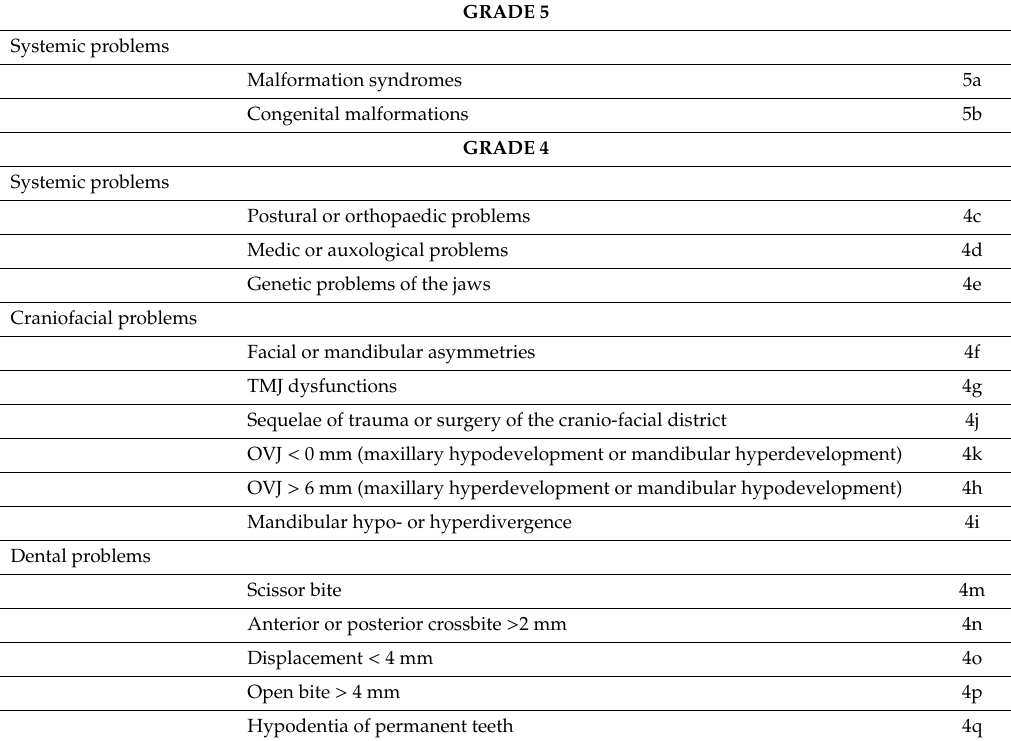
Table A1. ROMA index